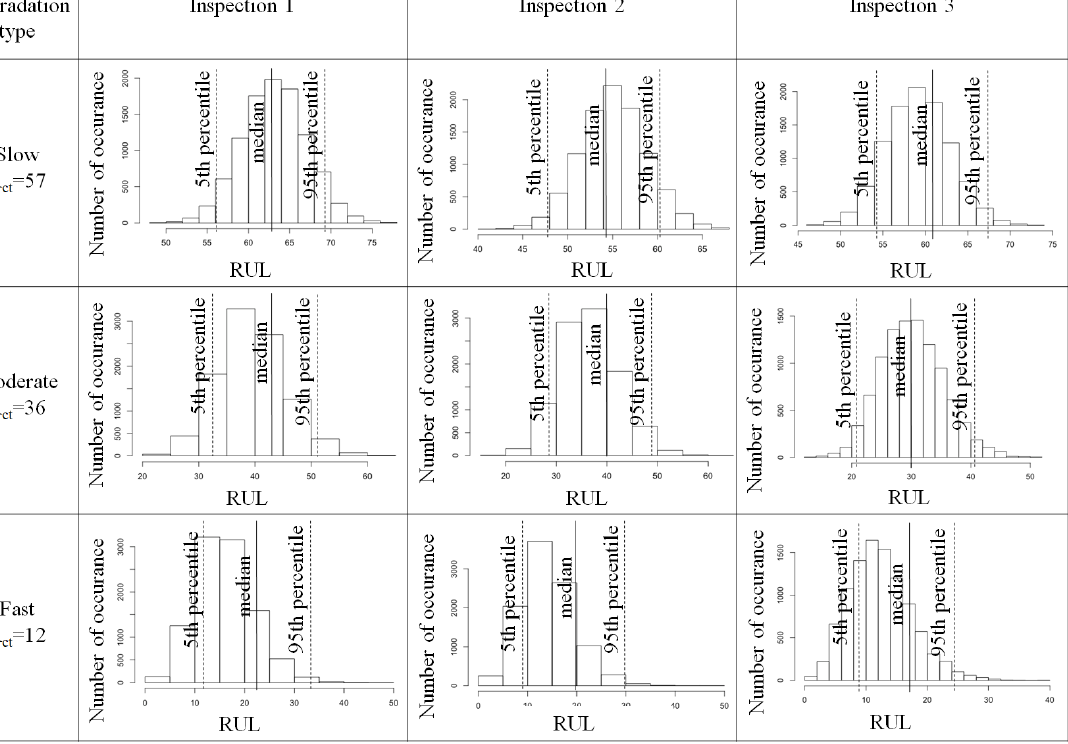
Figure 7. Position of the real crossing time R ct compared to the 5% and 95% percentiles of the RUL histograms for simulated data with the KNN algorithm at different inspection times: Slow, moderate, and